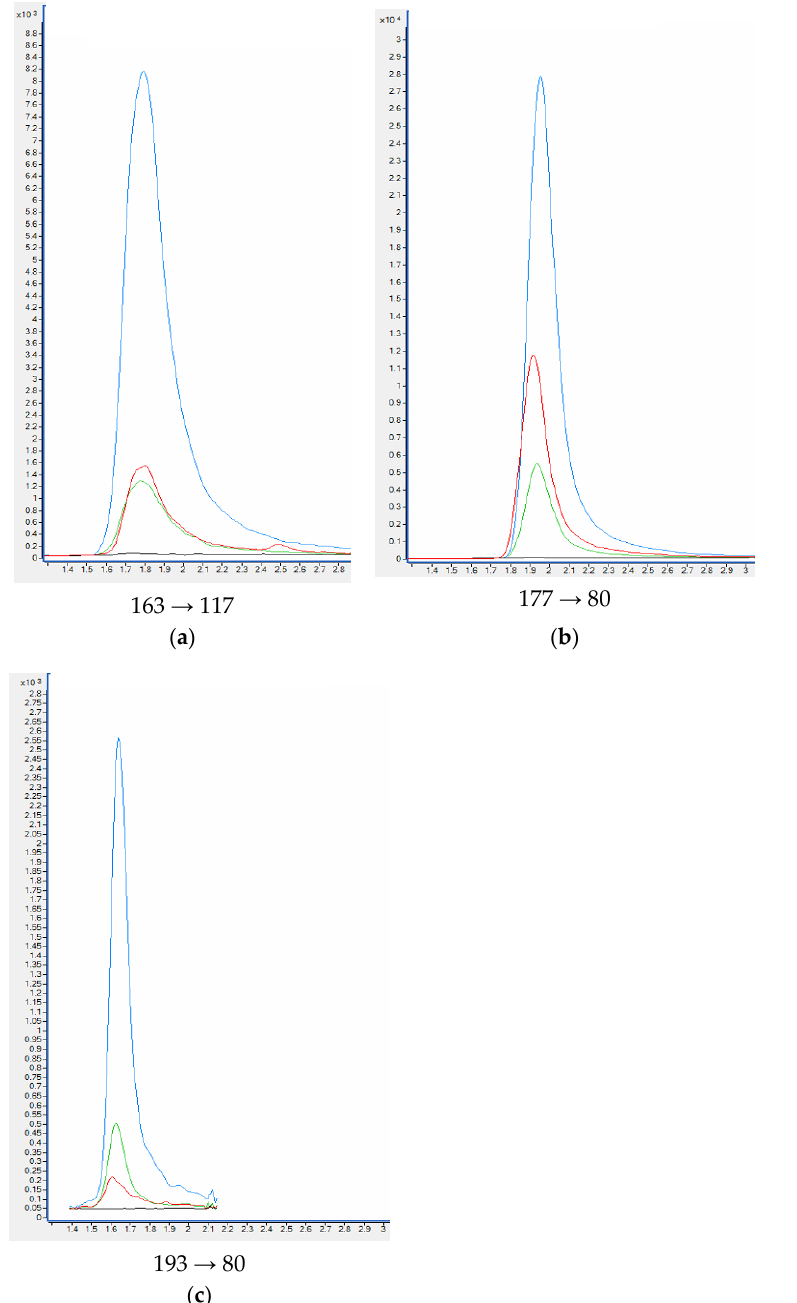
Figure 5. HPLC-QQQ-MS/MS chromatograms of quantitative transition of nicotine ( a ) and metab- olites: cotinine ( b ), trans -3 ′ -hydroksycotinine ( c ) from the blank plasma sample, plasma samples used in the validation process and smoker’ plasma sample. Plasma sample spiked with 100 ng mL − 1 of analytes (blue); Plasma sample spiked with 20 ng mL − 1 of analytes (green); smoker’ plasma sample (red); blank plasma sample (black).